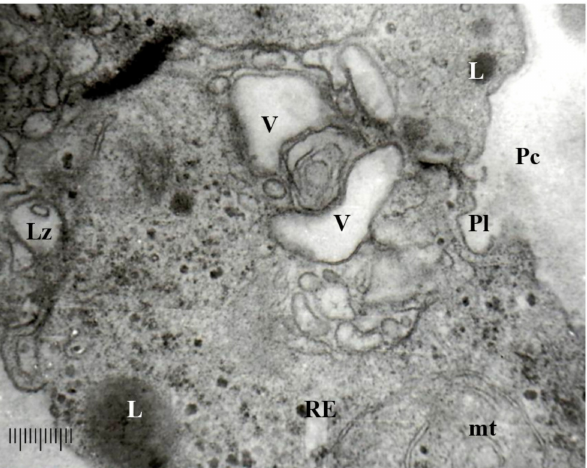
Figure 6. Details regarding the ultrastructural organization of some sectors from the subapical cells of some vegetative hyphae (transversal section): L—lipids; Lz—lysosomes; mt—mitochondria; N—nucleus; Pc—cell wall; Pl—plasmalema; RE—endoplasmic reticulum; V—vacuole; (bar—1 µ